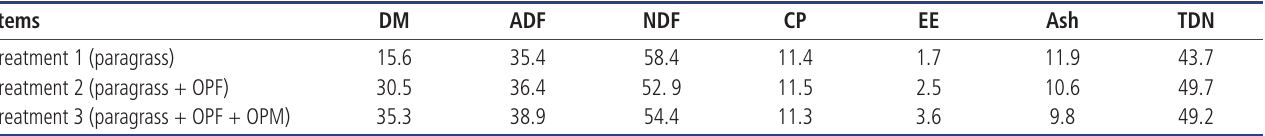
Table 1. Nutritional composition of experimental diets (% DM) Items DM